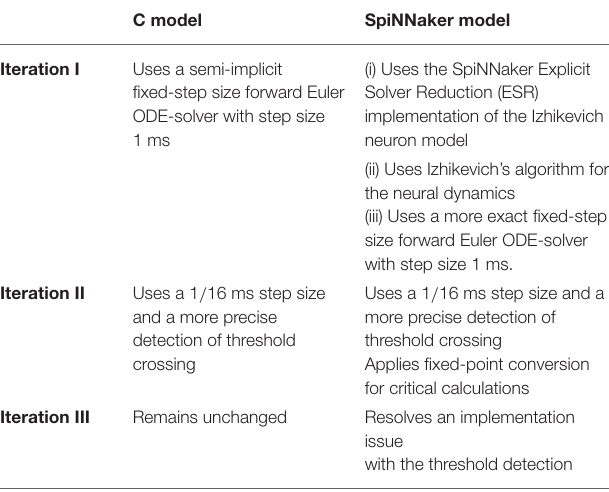
TABLE 1 | Summary of the development steps of the model